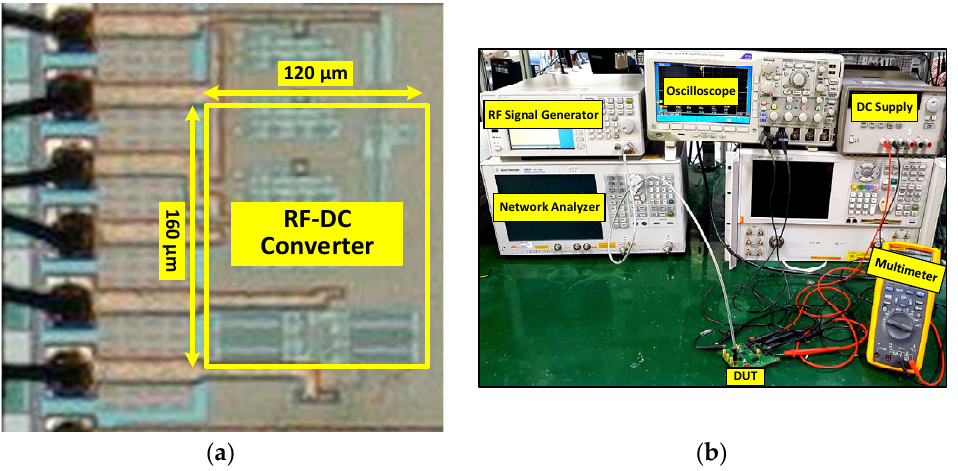
Figure 5. ( a ) Chip microphotograph and ( b ) measurement setup of the proposed RF-DC converter architecture.